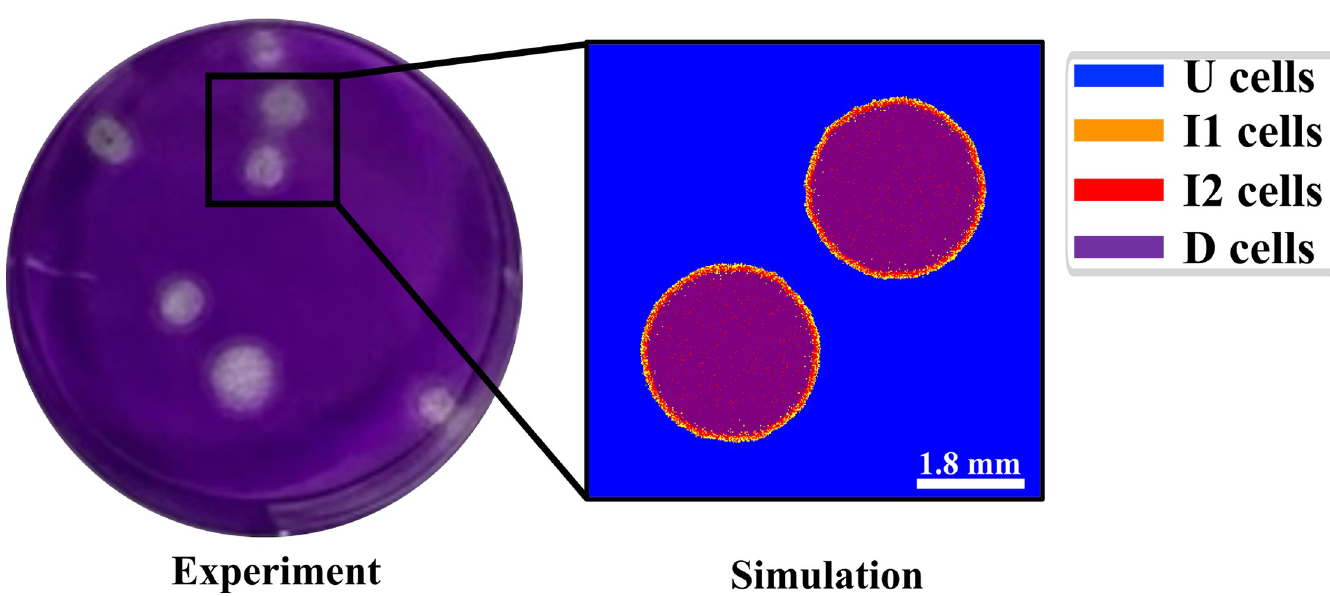
Fig 3. Comparison of an experimental plaque assay for influenza (H5N1; left) with an MSIS model plaque simulation (for H1N1; right). The simulation seeded two plaques in a simulation domain to replicate a subset of the experimental area. The simulated plaques have a similar structure to the experiment. Outlined area in the experimental image corresponds roughly to the area of the simulation